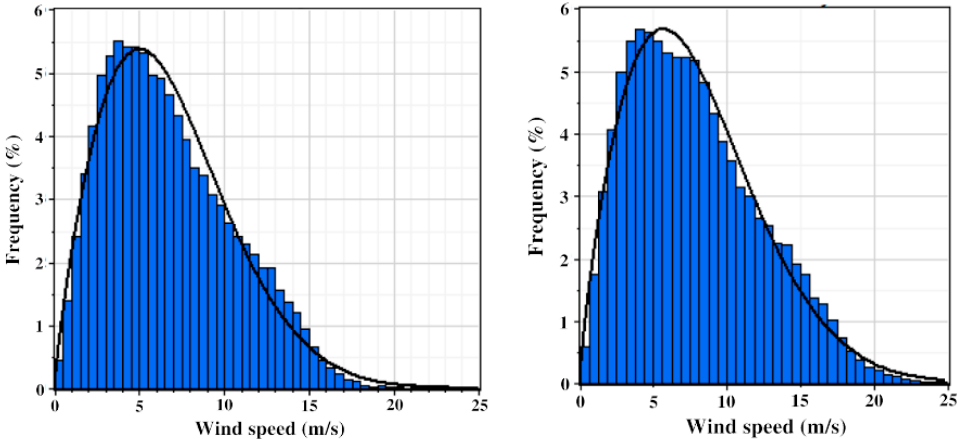
Figure 7. Weibull distribution at the floating LiDAR device ( left ) and mast ( right ) determined using MCP with MERRA location 2 data.